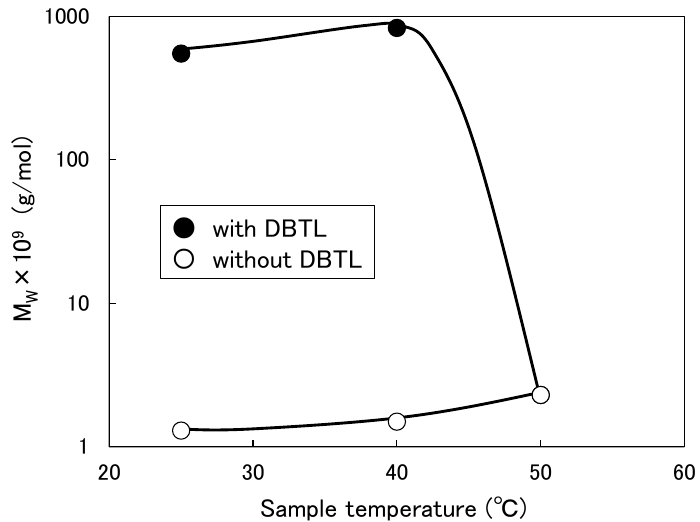
Figure 5. Relationship between the sample temperature and weight-average molecular weight (M W ) values of paints without additional solvent.